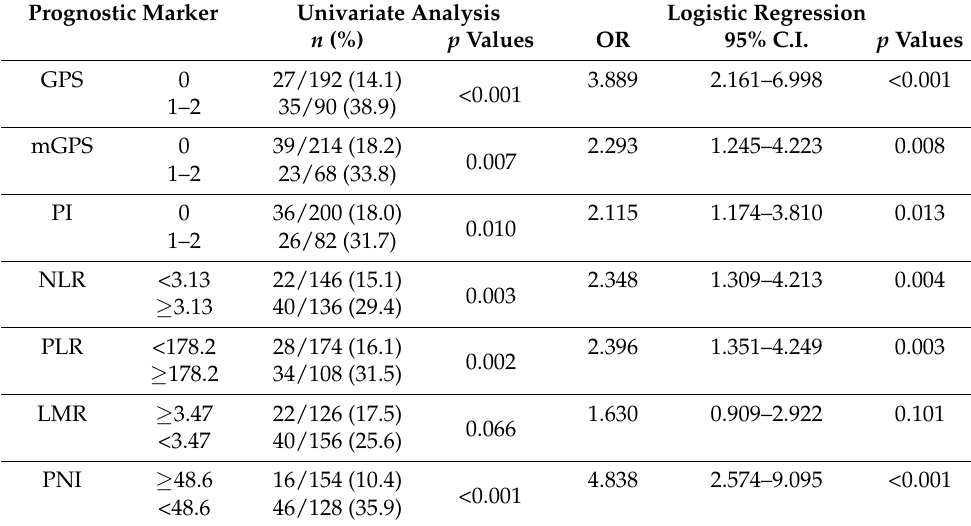
Table 6. Severe morbidity according to the different inflammatory and immune-nutritional